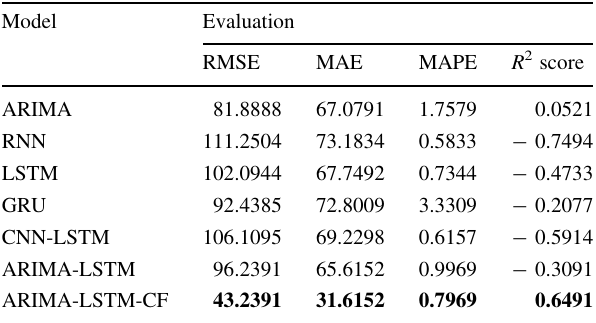
Table 5 Evaluation results of different prediction models